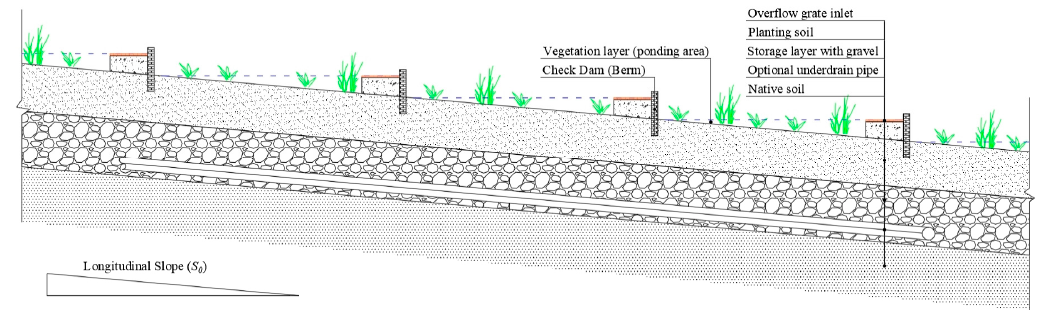
Figure 1. Schematic diagram of a continuous road-bioretention strip.